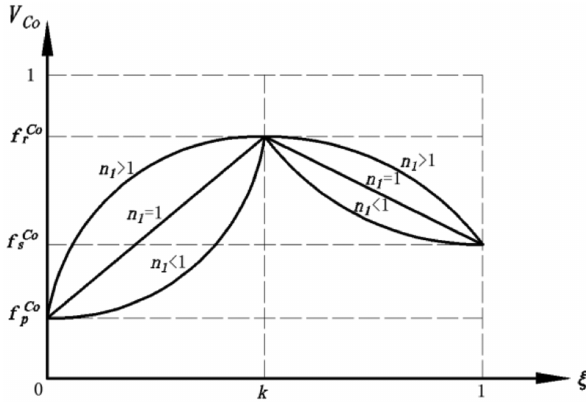
Figure 4: Volume fraction of Co with different distribution indices.